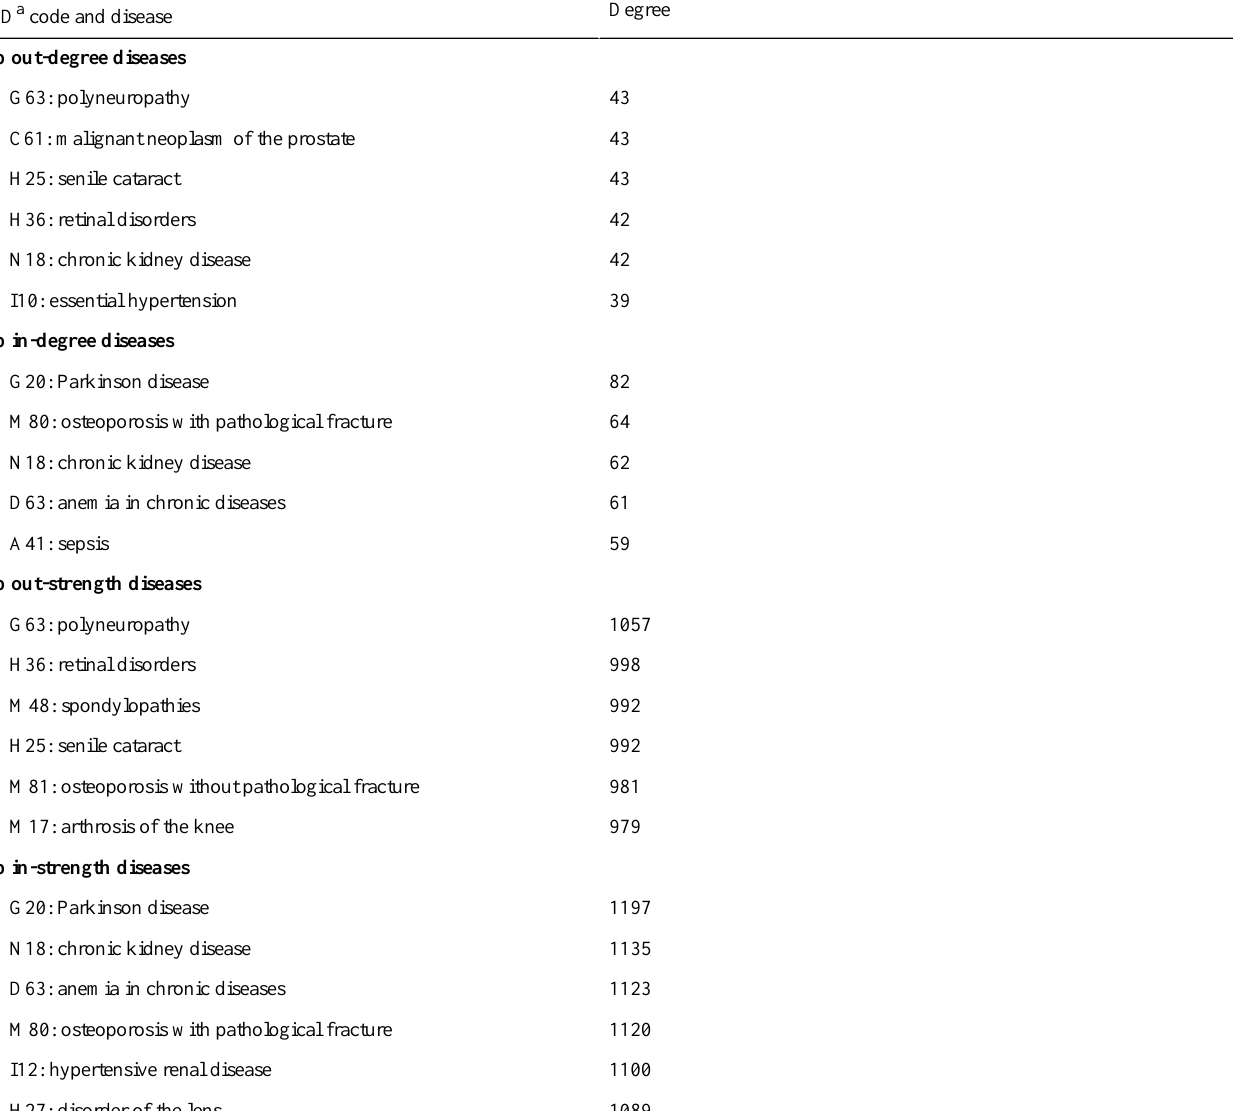
Table 3. Top out-/in-degree diseases and top out-/in-strength